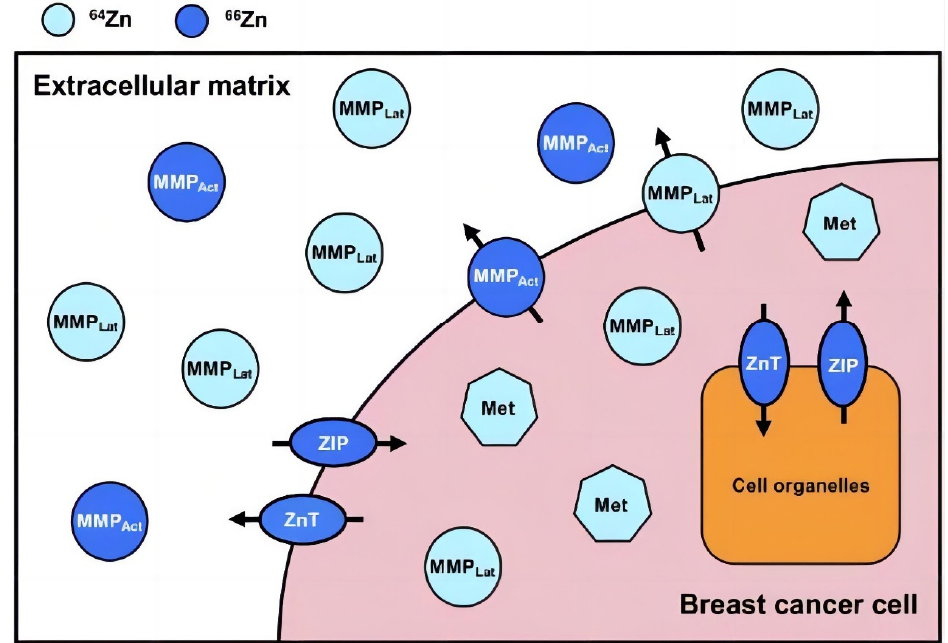
Figure 2. The distribution of Zn stable isotopes and their trafficking in and around a simplified breast cancer cell. Zinc in dark and light blue represents a relative enrichment in the heavy ( 66 Zn) and light ( 64 Zn) Zn isotope, respectively. ZIPs transport Zn into the cytoplasm both from outside the cell and from organelles. ZnTs transport Zn from the cytoplasm to both cell organelles and outside of the cell. Metallothionein and MMPs (both activated and latent) are strongly expressed compared to those in healthy breast tissue and benign tumors. Abbreviations: latent matrix metalloproteinase, MMP Lat (light blue circles); activated matrix metalloproteinase, MMP Act (dark blue circles); metallothionein, Met (light blue heptagons). Reproduced with permission [24]. Copyright © Oxford University Press 2021.